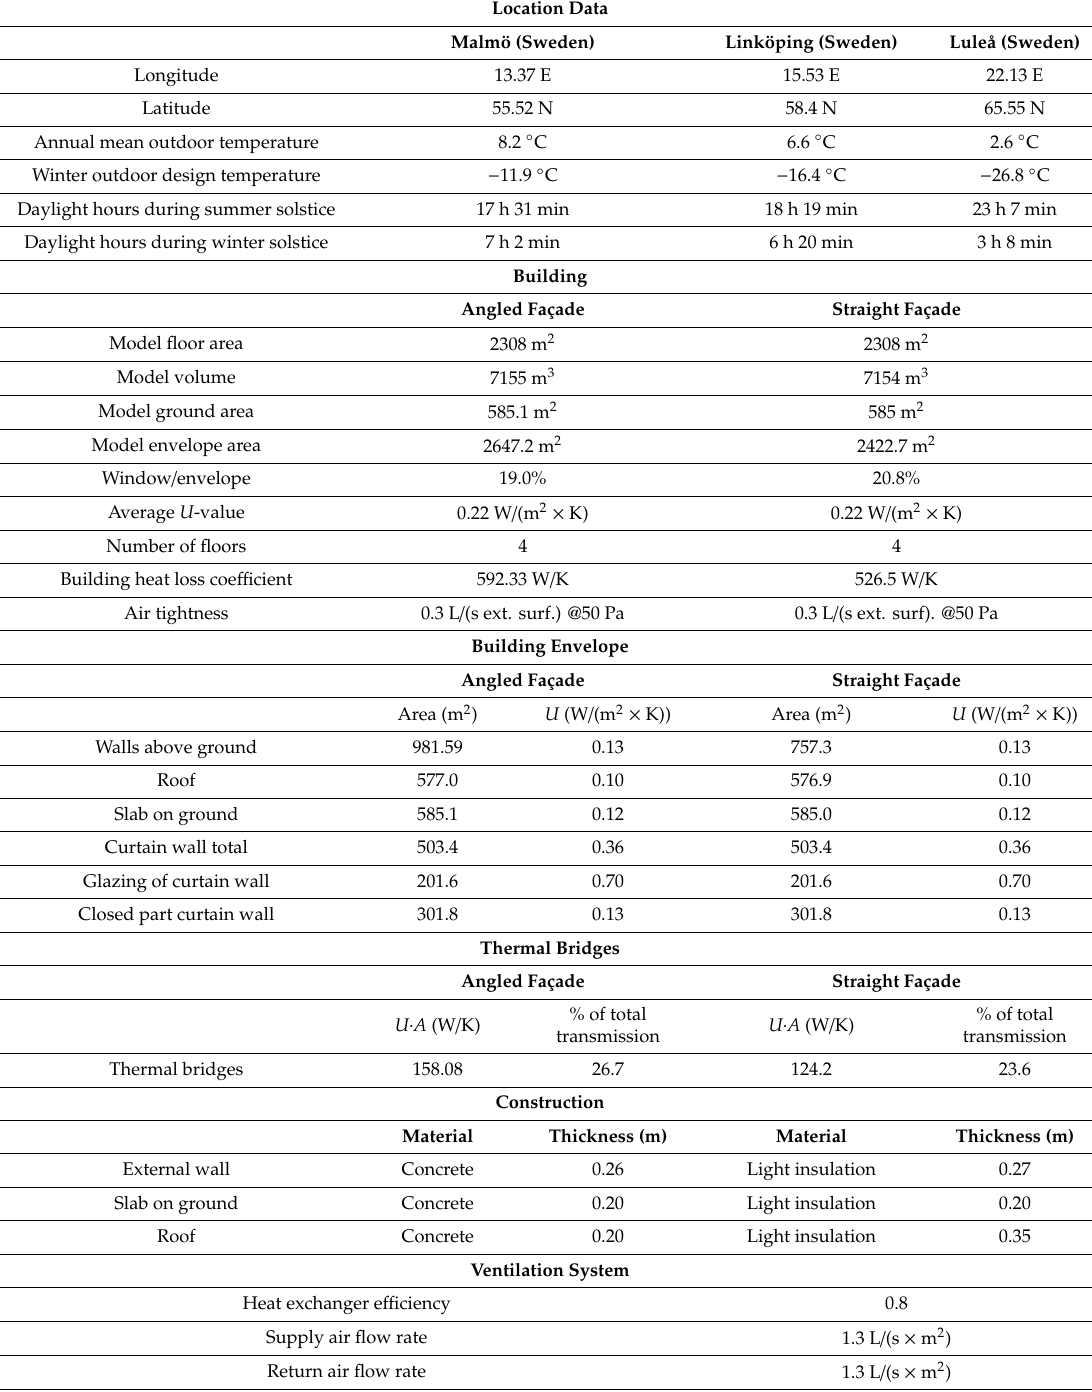
Table 1. Technical data of the two